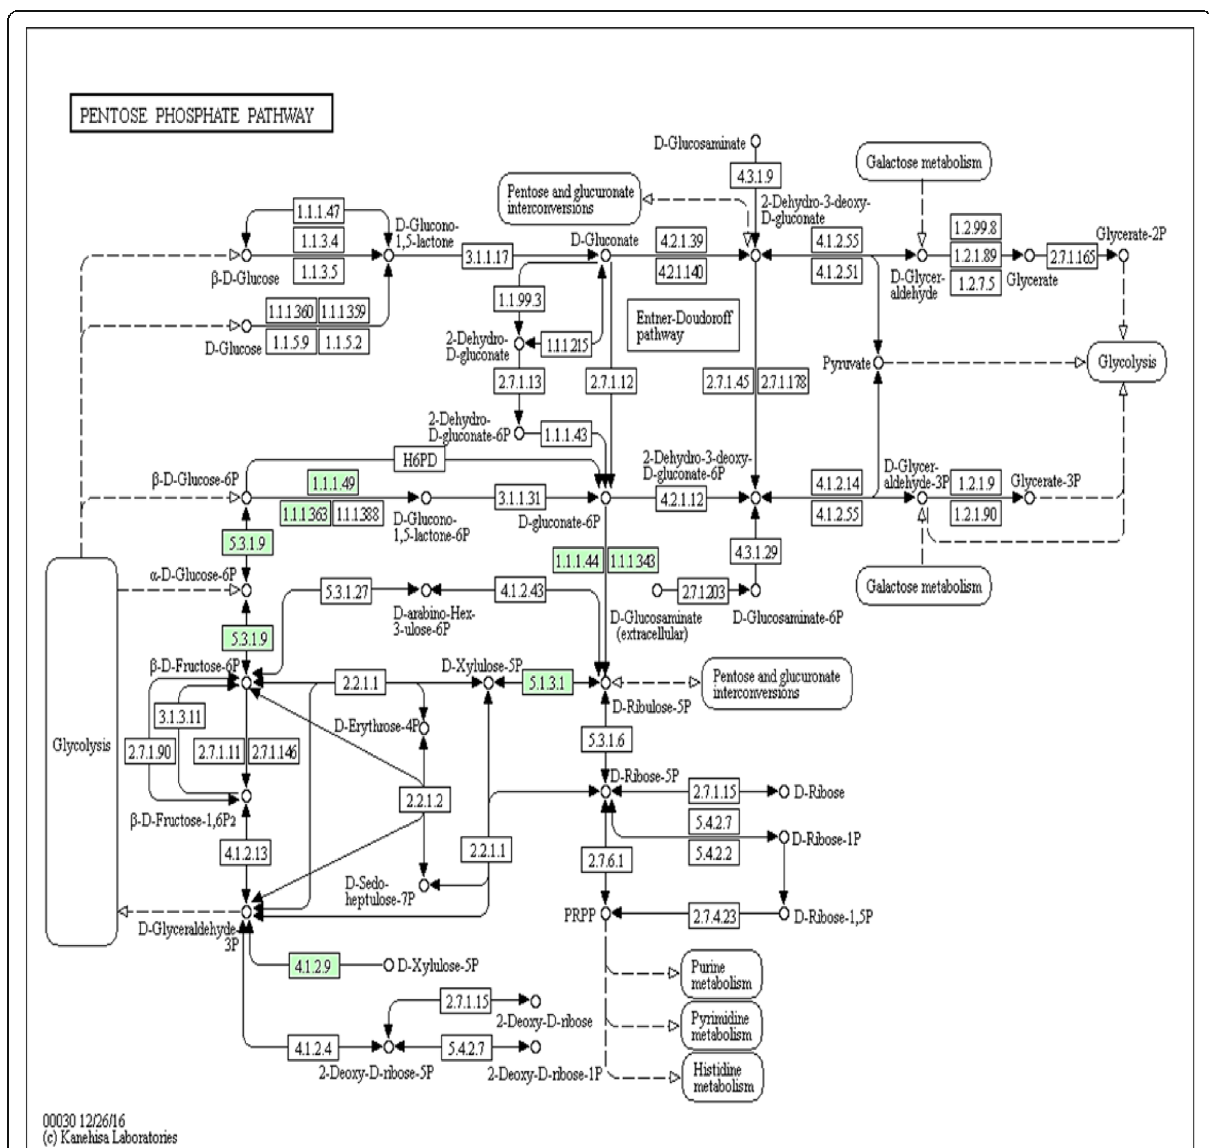
Fig. 3 Pentose phosphate pathway performed using the KEGG pathway in KEGG Orthology. EC numbers in green are the enzymes identified in AB1